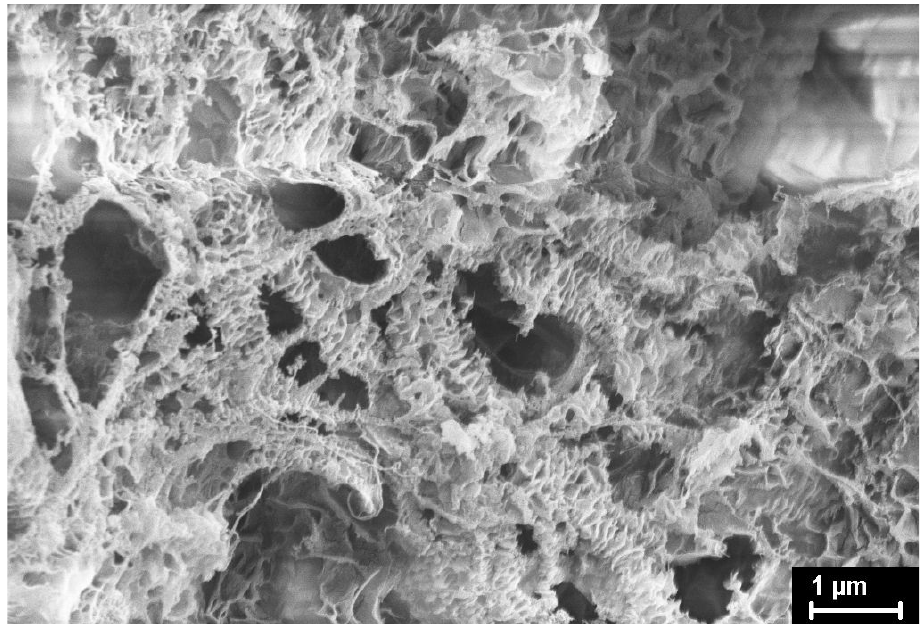
Figure 16. SEM micrograph of IVA7 reactor powder.